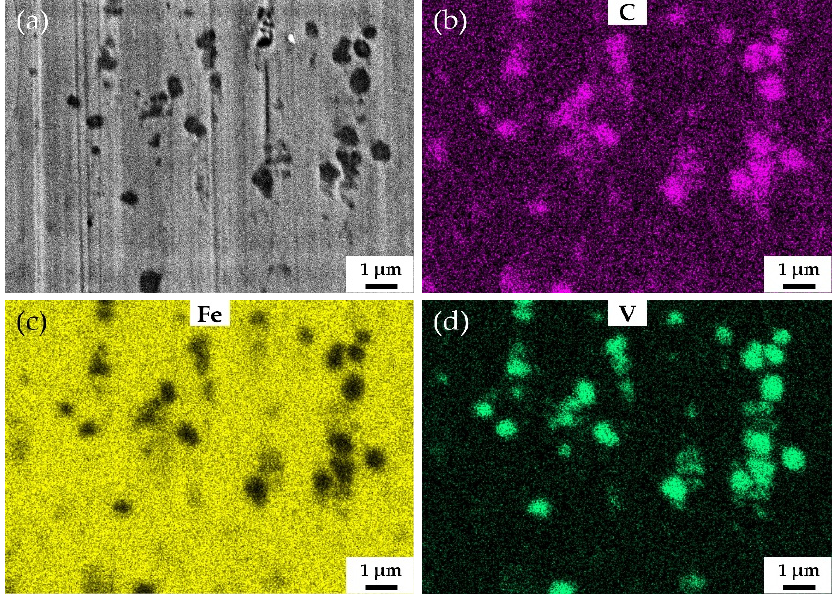
Figure 9. SEM and EDS mapping images of the surface of V3 quenched at 900 °C and tempered at 250 °C at high magnification after abrasive wear test. ( a ) SEM image, ( b ), ( c ) and ( d ) EDS mapping images of C, Fe and V, respectively.